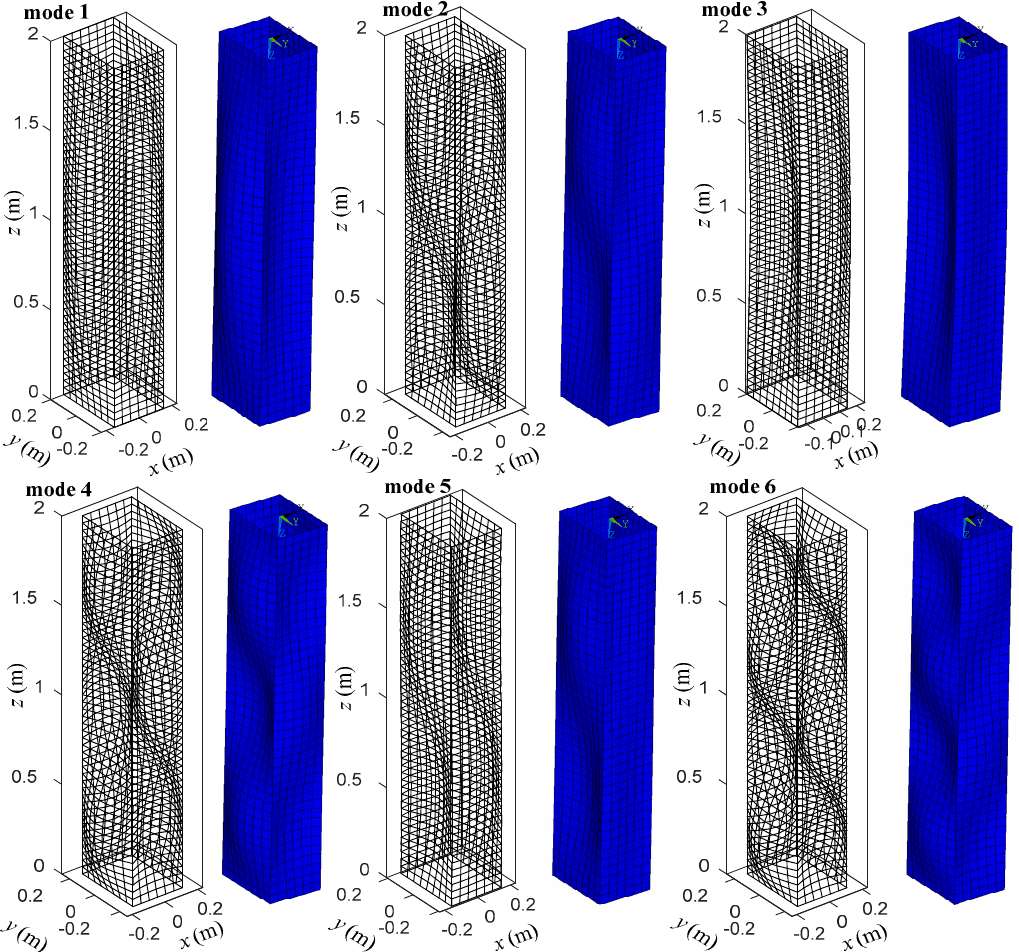
Figure 14. Comparison of the modal shapes of the fixed–fixed thin-walled structures, between the ANSYS shell model (the right ) and the present model (the left ).